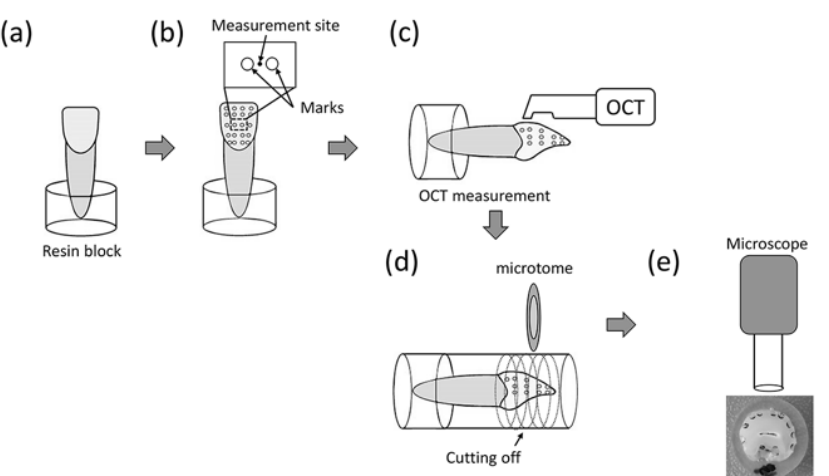
Figure A1. Schematic diagram of the experiment. ( a ) Specimens were arranged in acrylic resin with the tooth axis perpendicular; ( b ) A round bur with a diameter of 1 mm was used to mark sites approximately 1 mm on the left and right side of each of the 28 measurement sites on the specimens; ( c ) Enamel thickness in the center of each marked site perpendicular to the tooth axis was measured with OCT; ( d ) The specimens were completely covered in acrylic resin, and sections of H1 to H5 were prepared across the tooth axis; ( e ) Enamel thickness was measured at the center of each pair of marked sites on each section.